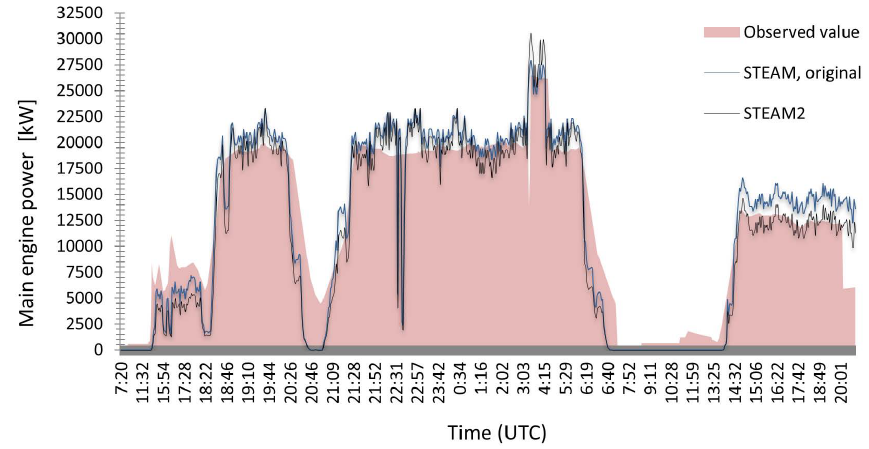
Fig. 7. The predictions of the STEAM and STEAM2 models and the corresponding measured engine power. The data has been measured for a 60000t RoPax vessel that was sailing in the Baltic Sea within and near the archipelago surrounding the city of Stockholm in April